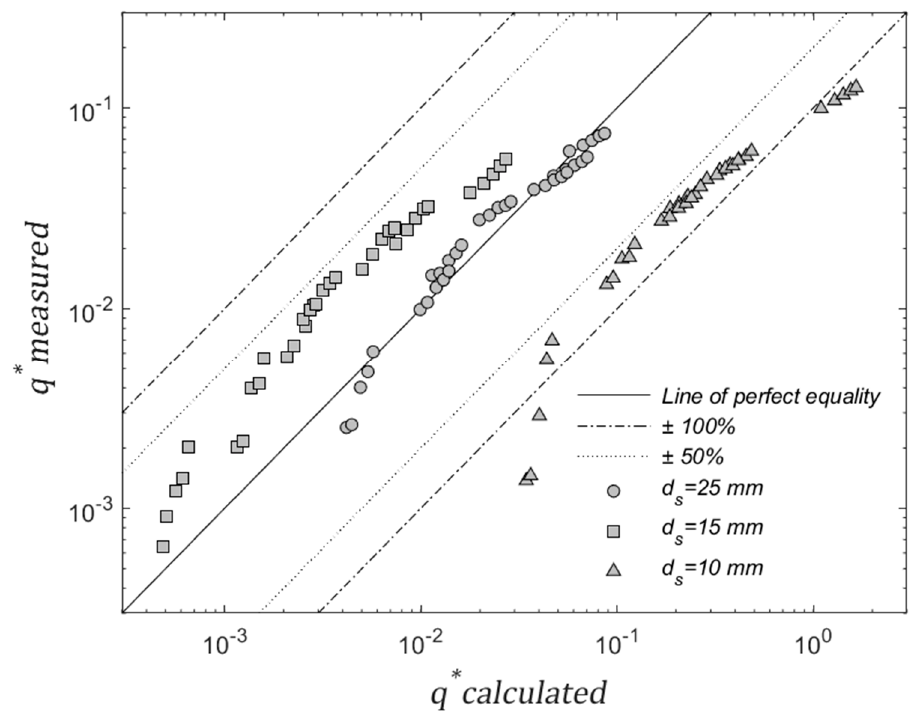
Figure 10. Comparison between measured and calculated bedload transport rates within the range of an order of magnitude of accuracy for d s =10 mm (Case A), d s =15 mm (Case B), d s =25 mm (Case C).